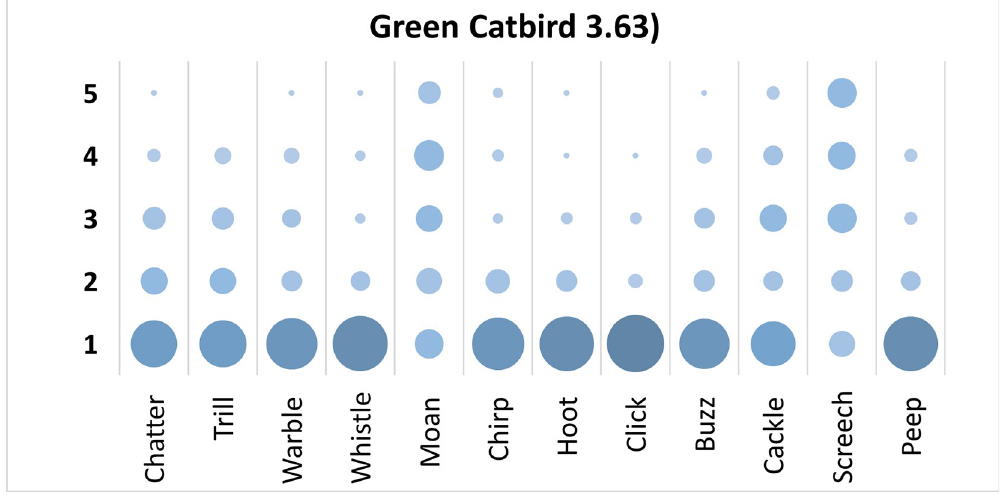
Fig 9. Count of participants’ sound descriptions scores for the Green Catbird with confidence ratings in brackets.